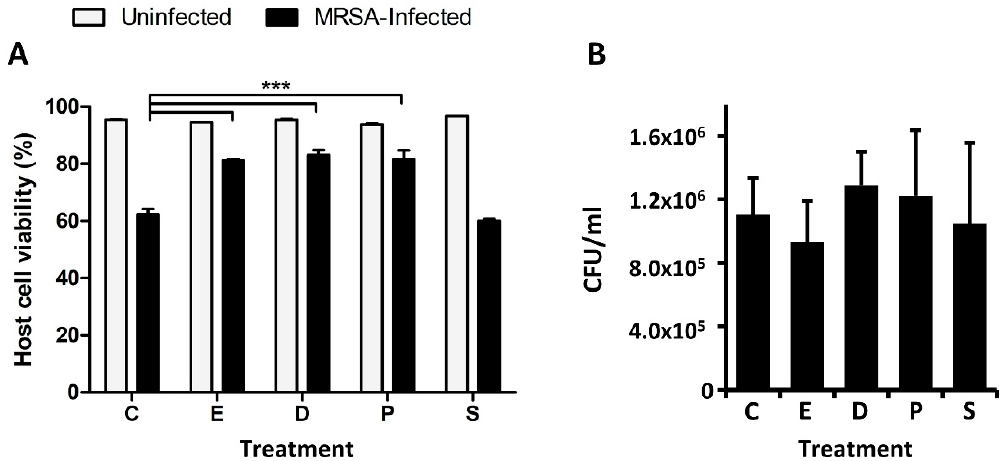
Figure 3. Treating HeLa cells with eicosanoic, docosanoic or palmitic acid increases host cell viability after USA300 infection but does not a ff ect MRSA intracellular survival. HeLa cells were infected with USA300 (MOI 100; 6 h) in the presence of DMSO ( C ), docosanoic acid ( D ), eicosanoic acid ( E ), palmitic acid ( P ) and stearic acid ( S ), and host cell viability was quantified. ( A ) Quantification of host cell viability after USA300 infection was measured by flow cytometry using a double annexin V-FITC and PI staining. ( B ) Intracellular MRSA survival quantified by colony forming units per milliliter (CFU / mL). Data are expressed as means ± SE of three independent experiments performed in duplicates. One-way ANOVA and post hoc Tukey’s multiple comparison tests were performed to assess statistically significance across treatments. p -value ≤ 0.001 (***).